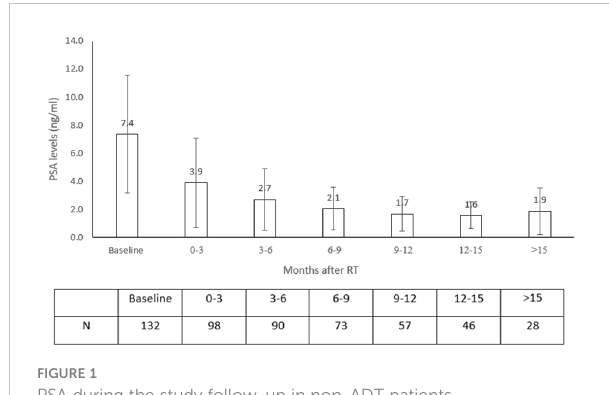
FIGURE 1 PSA during the study follow-up in non-ADT